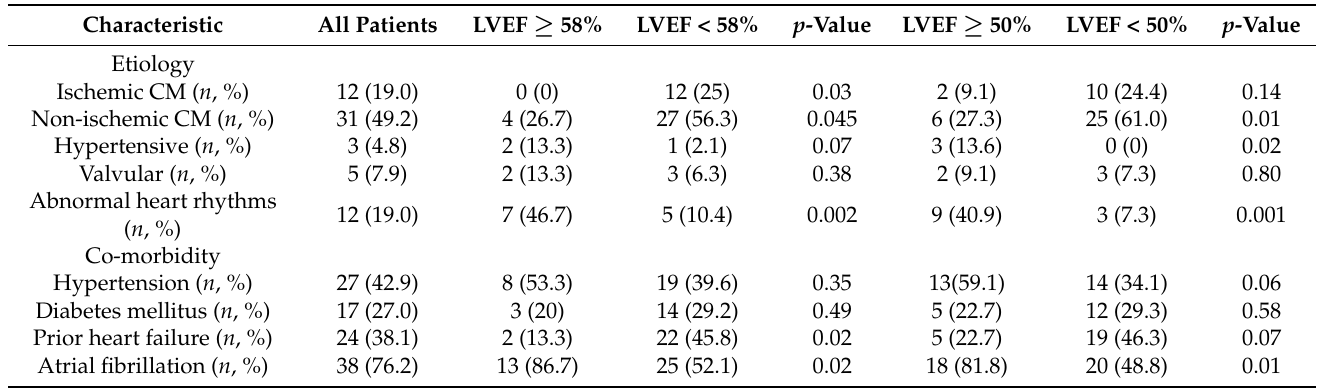
Table 2. Comparisons of underlying disease.